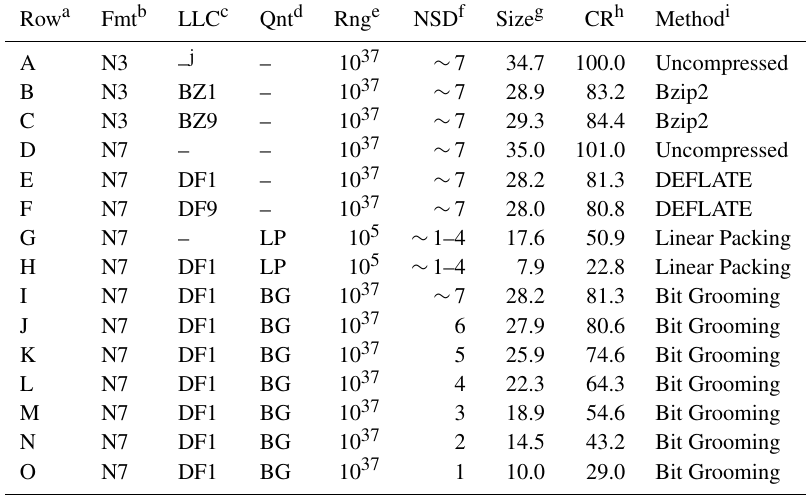
Table 4. Compression ratios for low-resolution initially uncompressed model netCDF3